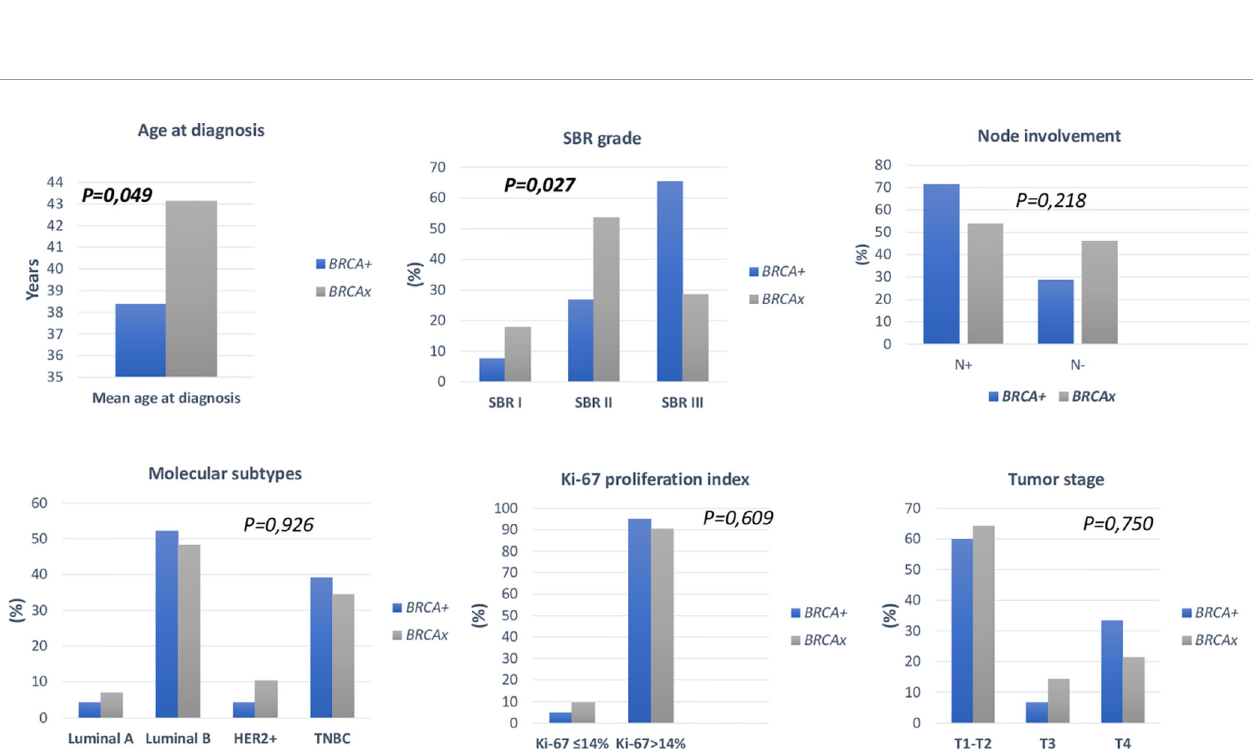
FIGURE 5 | Distribution of clinico-pathological features of breast cancer in BRCA + and BRCAx patients.